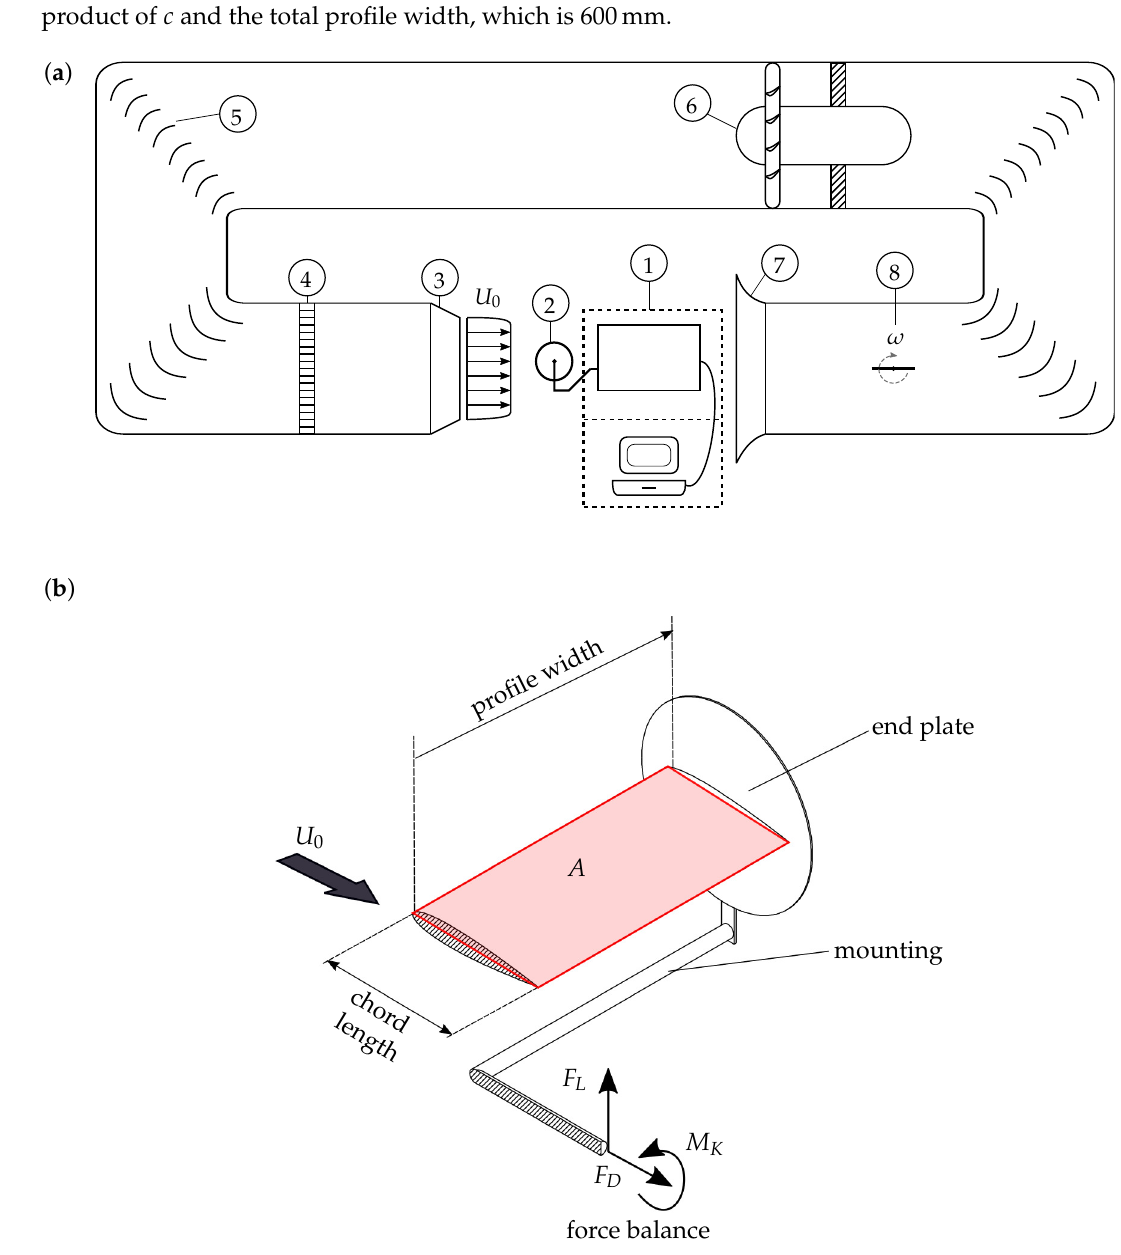
Figure 2. ( a ) Sketch of the experimental set-up: 1 (cid:13) Force balance with measuring system; 2 (cid:13) NACA0020 profile with mounting; 3 (cid:13) nozzle; 4 (cid:13) flow straightener; 5 (cid:13) vanes; 6 (cid:13) fan; 7 (cid:13) collector; 8 (cid:13) rotating plate; ( b ) close-up of the mounting with the profile, which is cross-sectionally